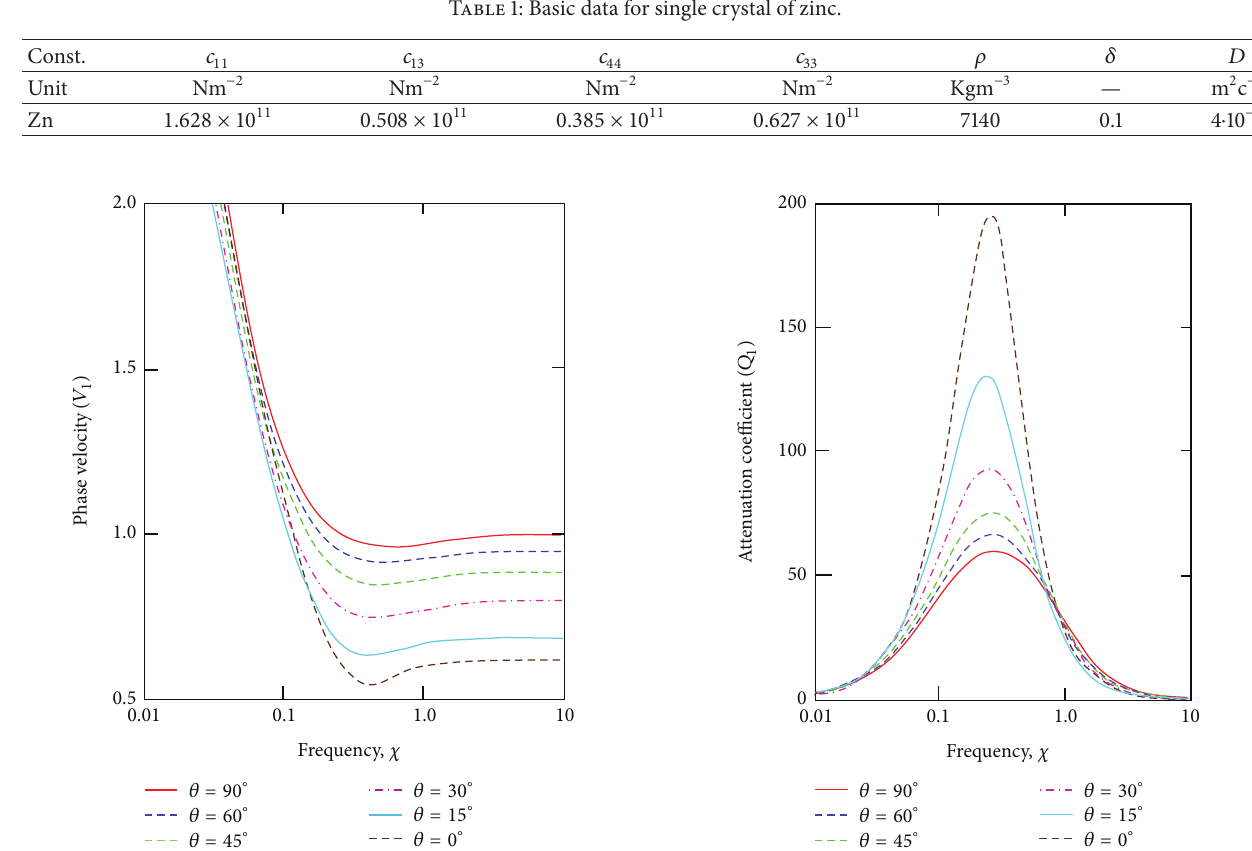
Figure 3: Variation of QL attenuation coefficient with nondimen- sional frequency in various direction of